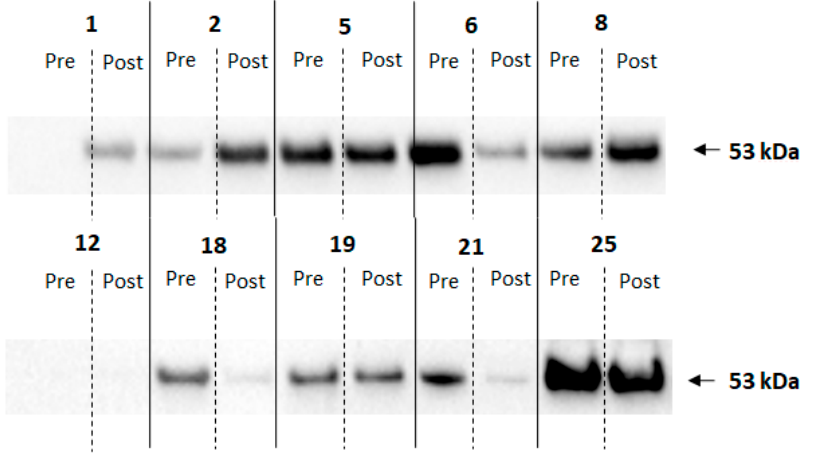
Figure 4. Western blotting of saliva probing from periodontal patients for MMP8. The numbers correspond to the patient; Pre indicates saliva sample and Post after surgery.